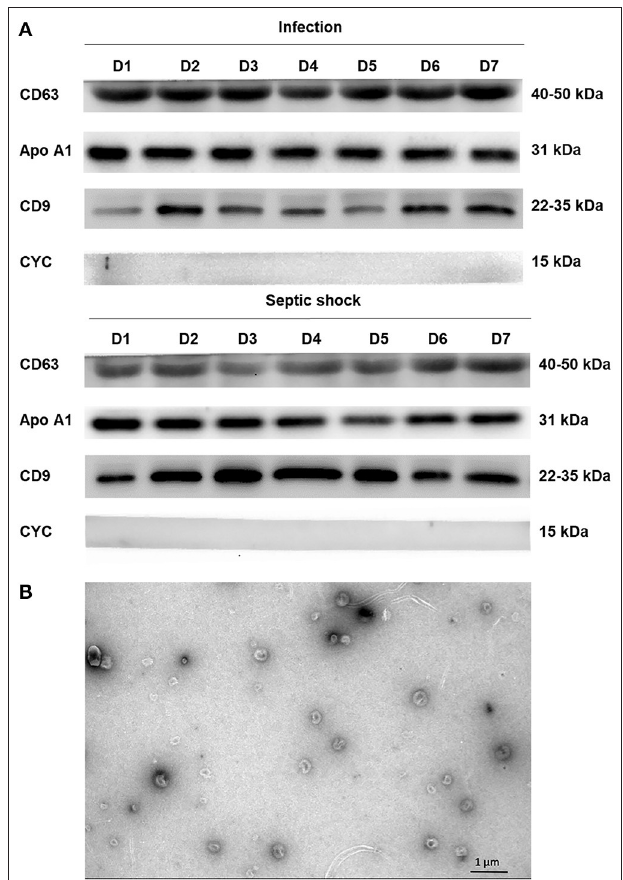
FIGURE 3 | Assessing extracellular vesicle isolates by western blot and electron microscopy. Using the differential centrifugation technique, EVs were concentrated and separated from PFP samples of septic shock and infected patients. The isolates were examined with western blot using the standard SDS-PAGE method and JEM-2101 transmission electron microscope (TEM). Western blot confirmed the presence of extracellular vesicles (i.e., CD9, CD63 positivity) and the absence of co-isolated contaminants of cell debris (i.e., CYC1 negativity) (A) . As demonstrated by ApoA1 positivity, there was some degree of lipoprotein contamination within the isolates from both septic shock and infected patients. TEM illustrated numerous single EVs and the absence of protein aggregates or other amorphous substances within the isolates (B) . Morphologically, EVs appeared as a cup-shaped structure with an approximate size of around 100–200nm. ApoA1, Apolipoprotein A1; CD, cluster of differentiation; CYC1, cytochrome C1; EV, extracellular vesicle; PFP, platelet-free